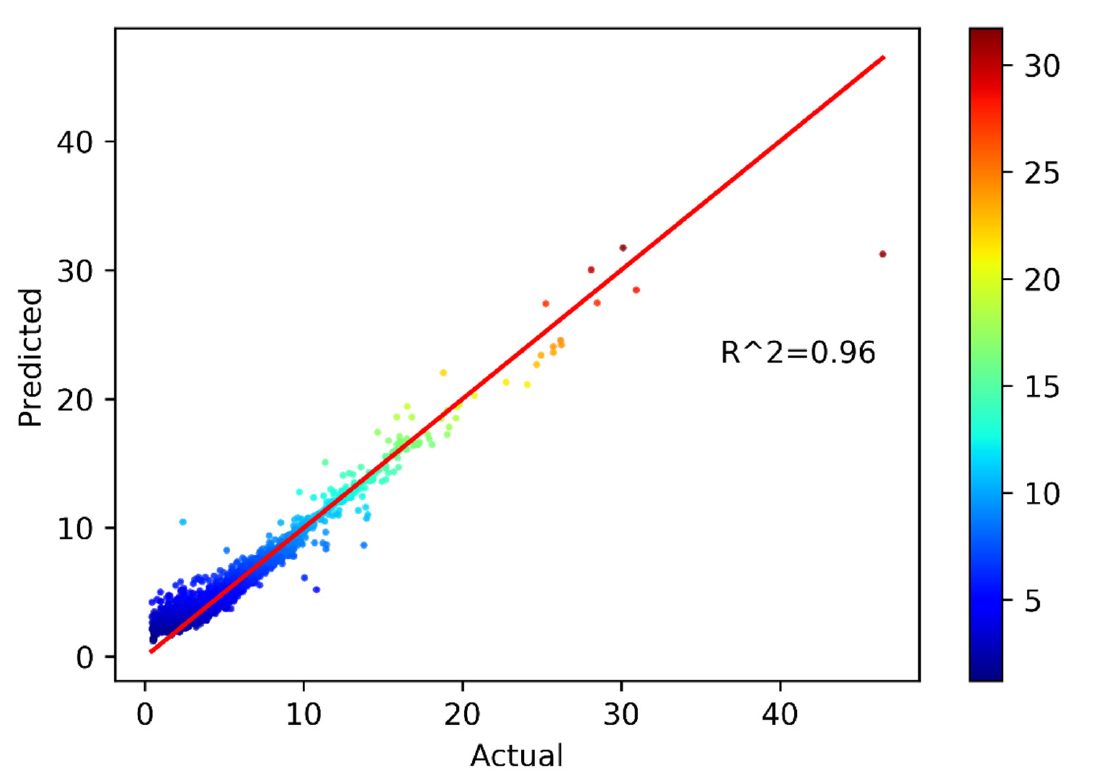
Figure 5. Actual and predicted property prices based on training set (RF).